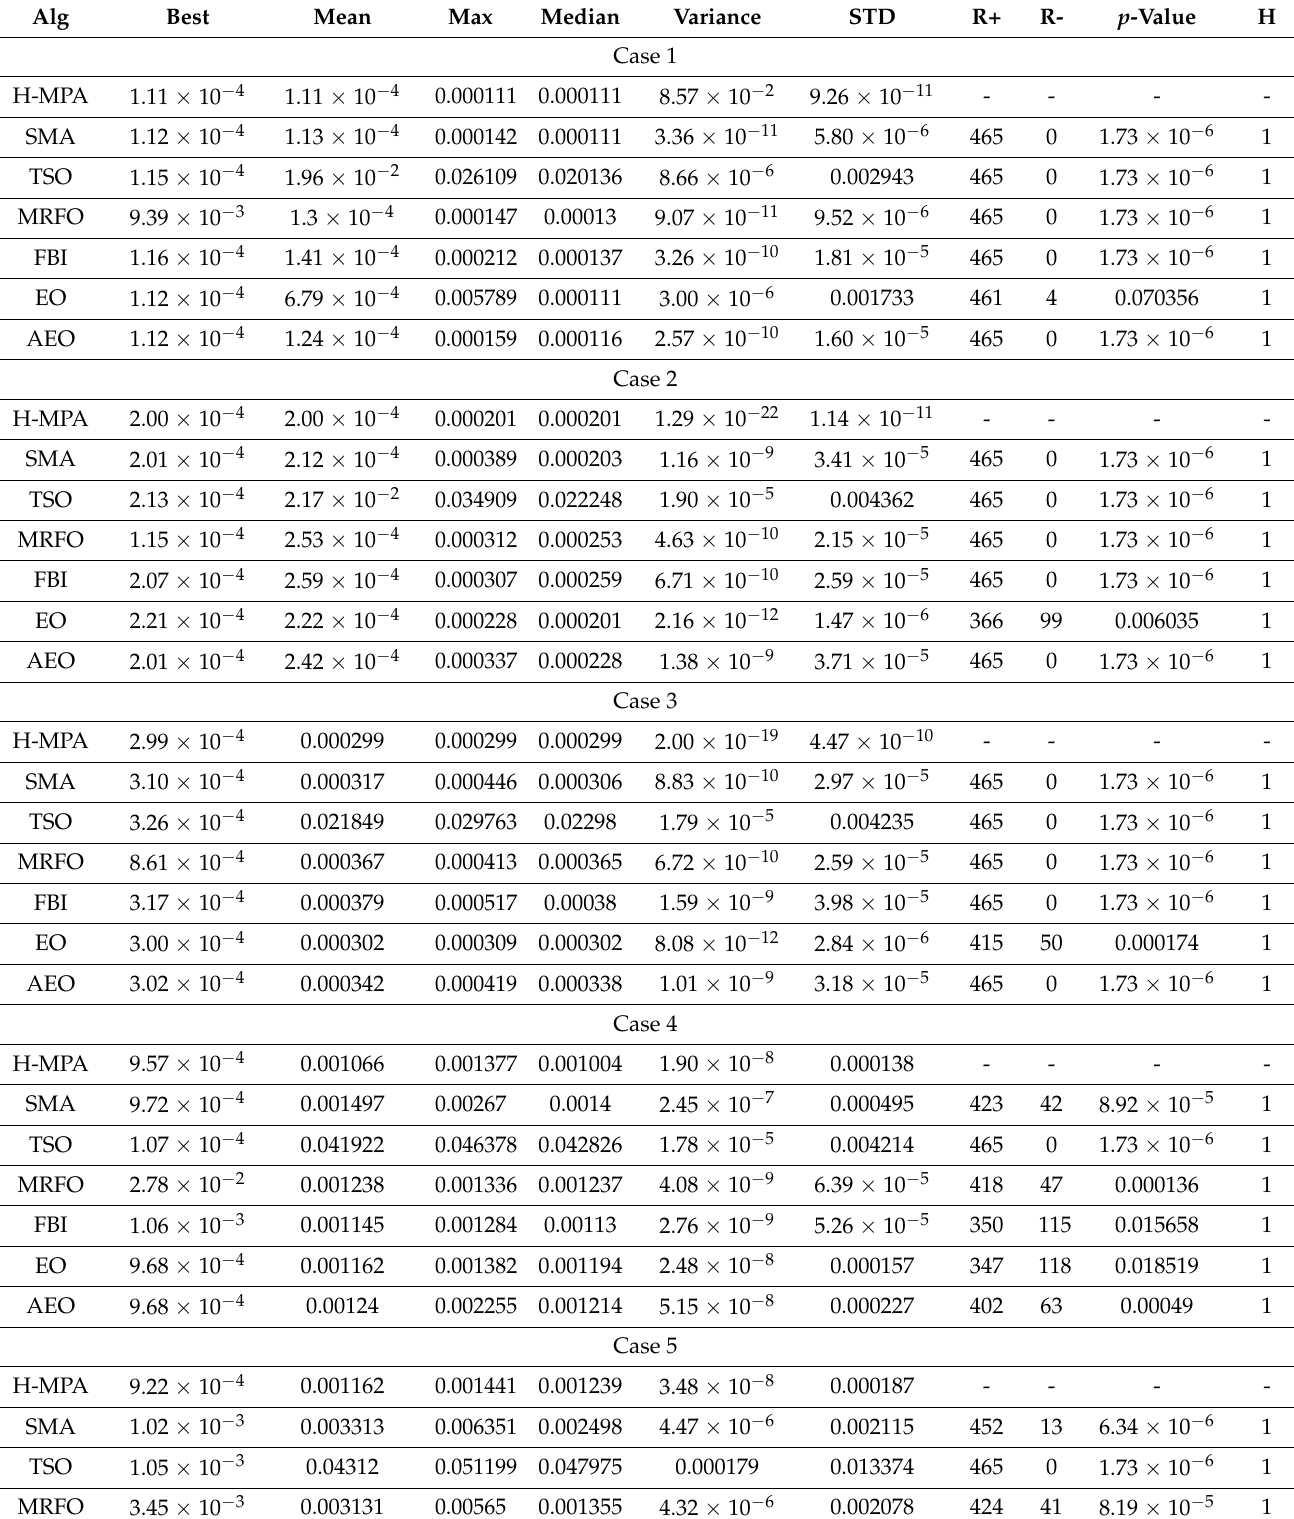
Table 4. The statistical analyses and non-parametric tests for H-MPA versus other